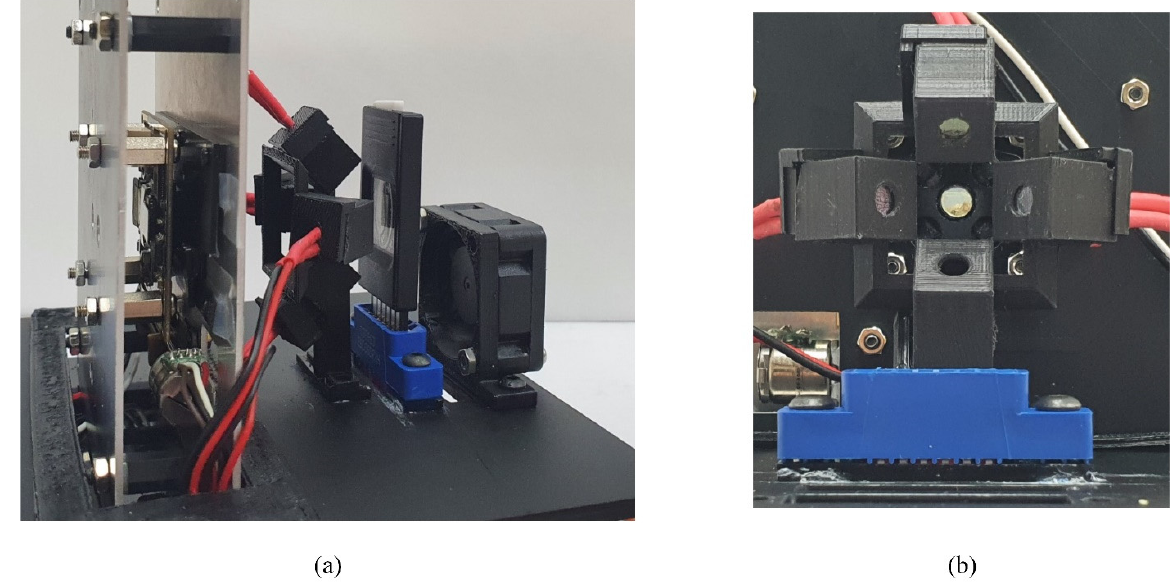
Figure 3. Overall four-color multiplex qPCR chip system and the excitation unit. ( a ) Overall four-color multiplexed qPCR chip system; ( b ) The front view of the excitation unit. Table 1. Center wavelength (CWL) and full width at half-maximum (FWHM) of excitation and emission filters used in the proposed system.